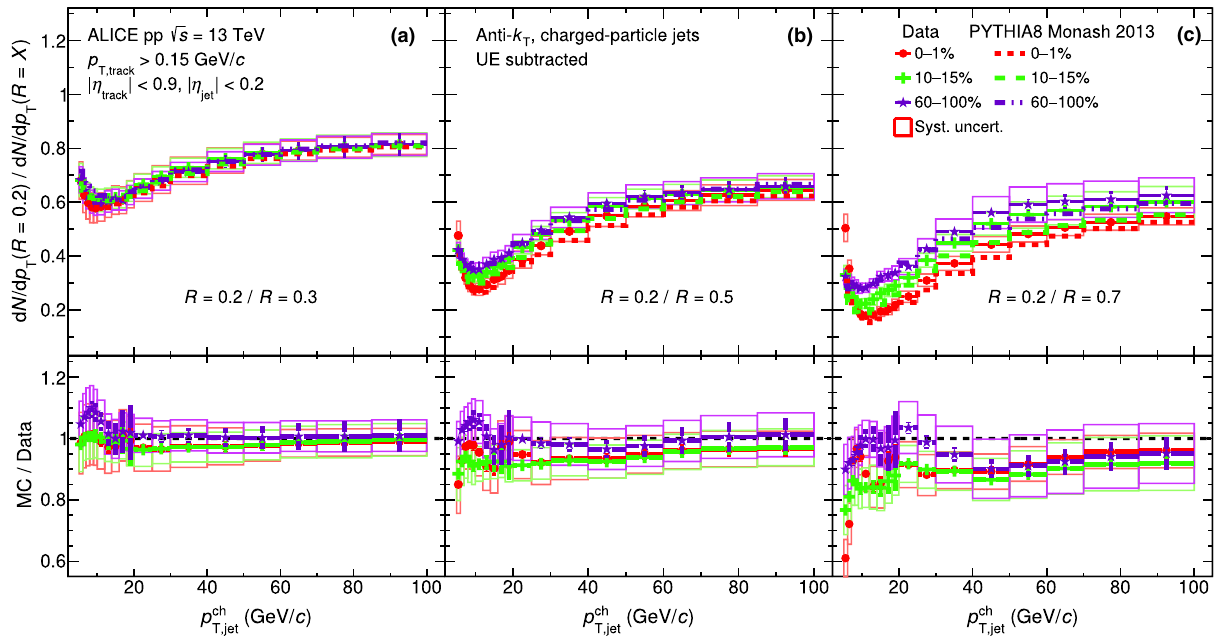
Fig. 11 Comparison of jet spectra ratios of R = 0 . 2 to R = 0 . 3 (a) , 0 . 5 (b) , 0 . 7 (c) in three multiplicity intervals (0–1%, 10–15% and 60– 100%) and compared with PYTHIA8 simulations. Statistical and sys-